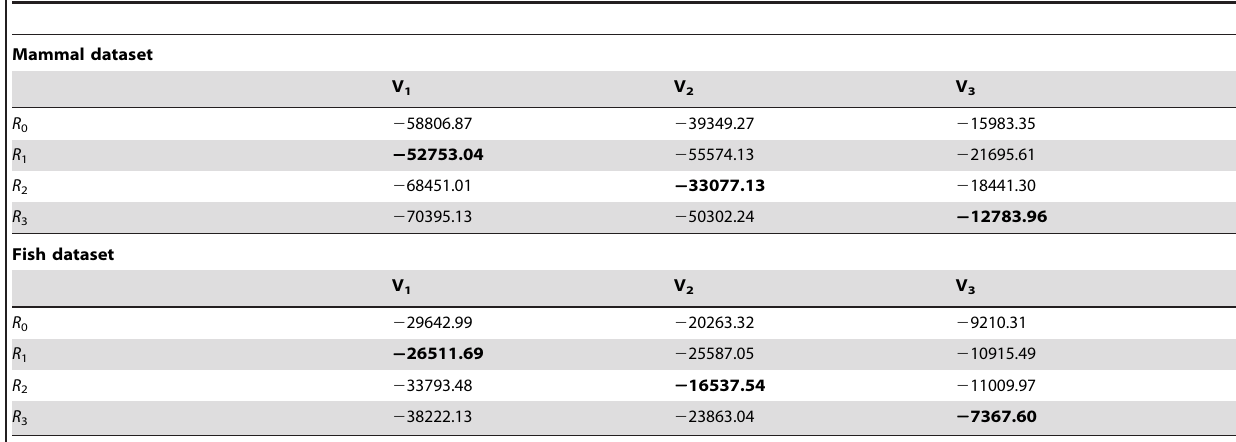
Table 5. Results from one replicate of the 50% cross-validation of the likelihood score for alternative rate matrices ( R i ).